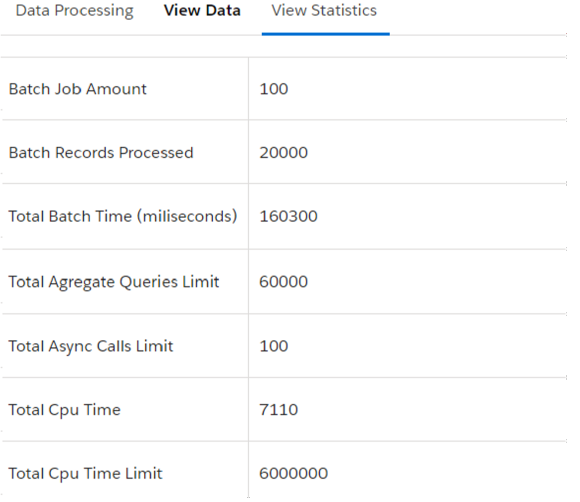
Figure 4. View Statistics tab of Salesforce data processor application created to analyze the data processing